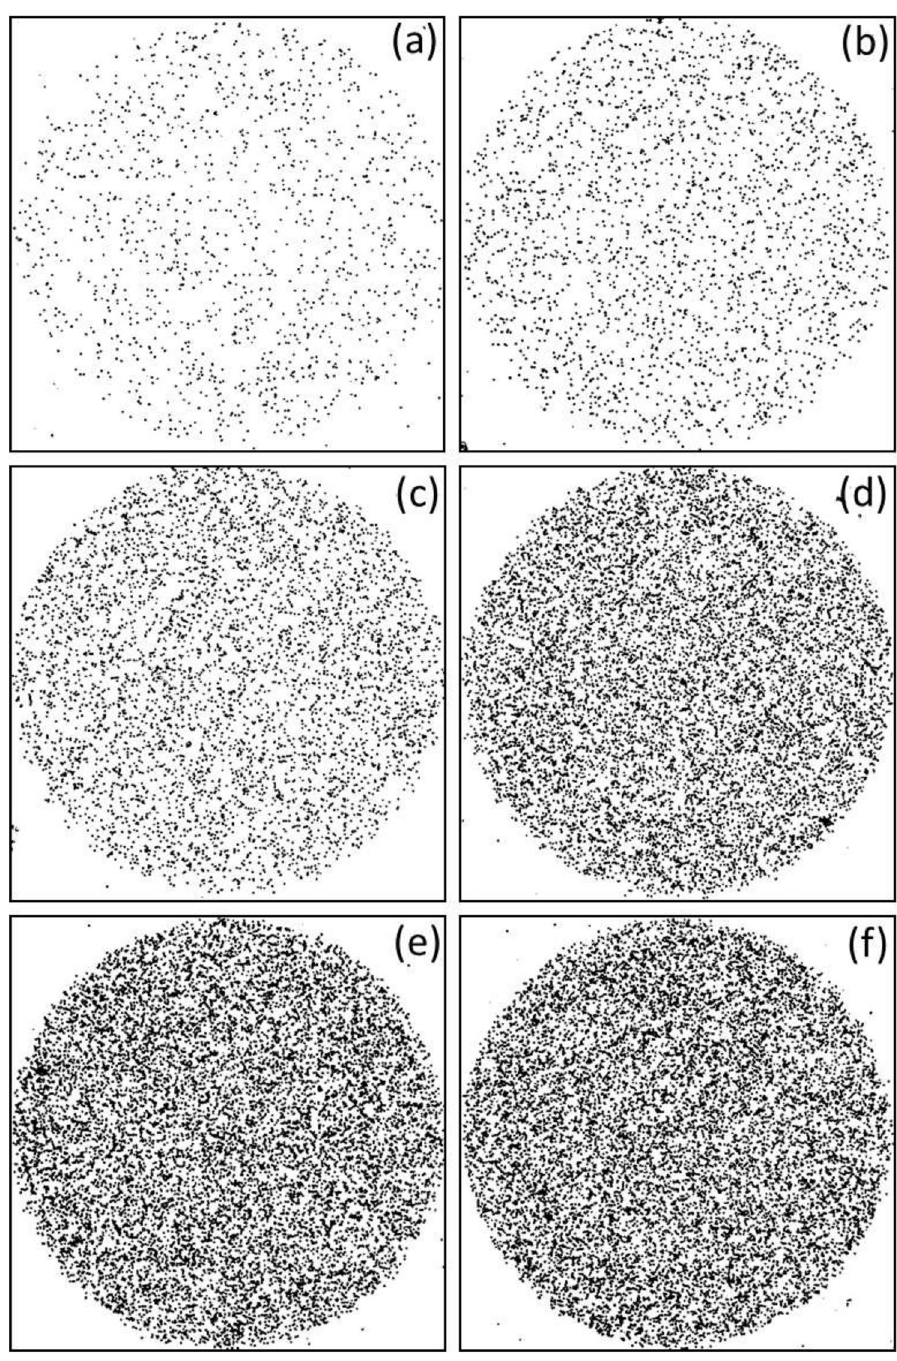
Figure 4. Photomicrographs of alpha particle tracks in PADC detector exposed for alpha particles of 4 MeV for different durations ( a ) 0.5 min, ( b ) 1 min, ( c ) 2 min, ( d ) 3 min, ( e ) 4 min, and ( f ) 5 min, PADC detector is chemically etched in 6.25 N NaOH at 70 ± 1 ◦ C for 4 h. The area of the picture is 1583